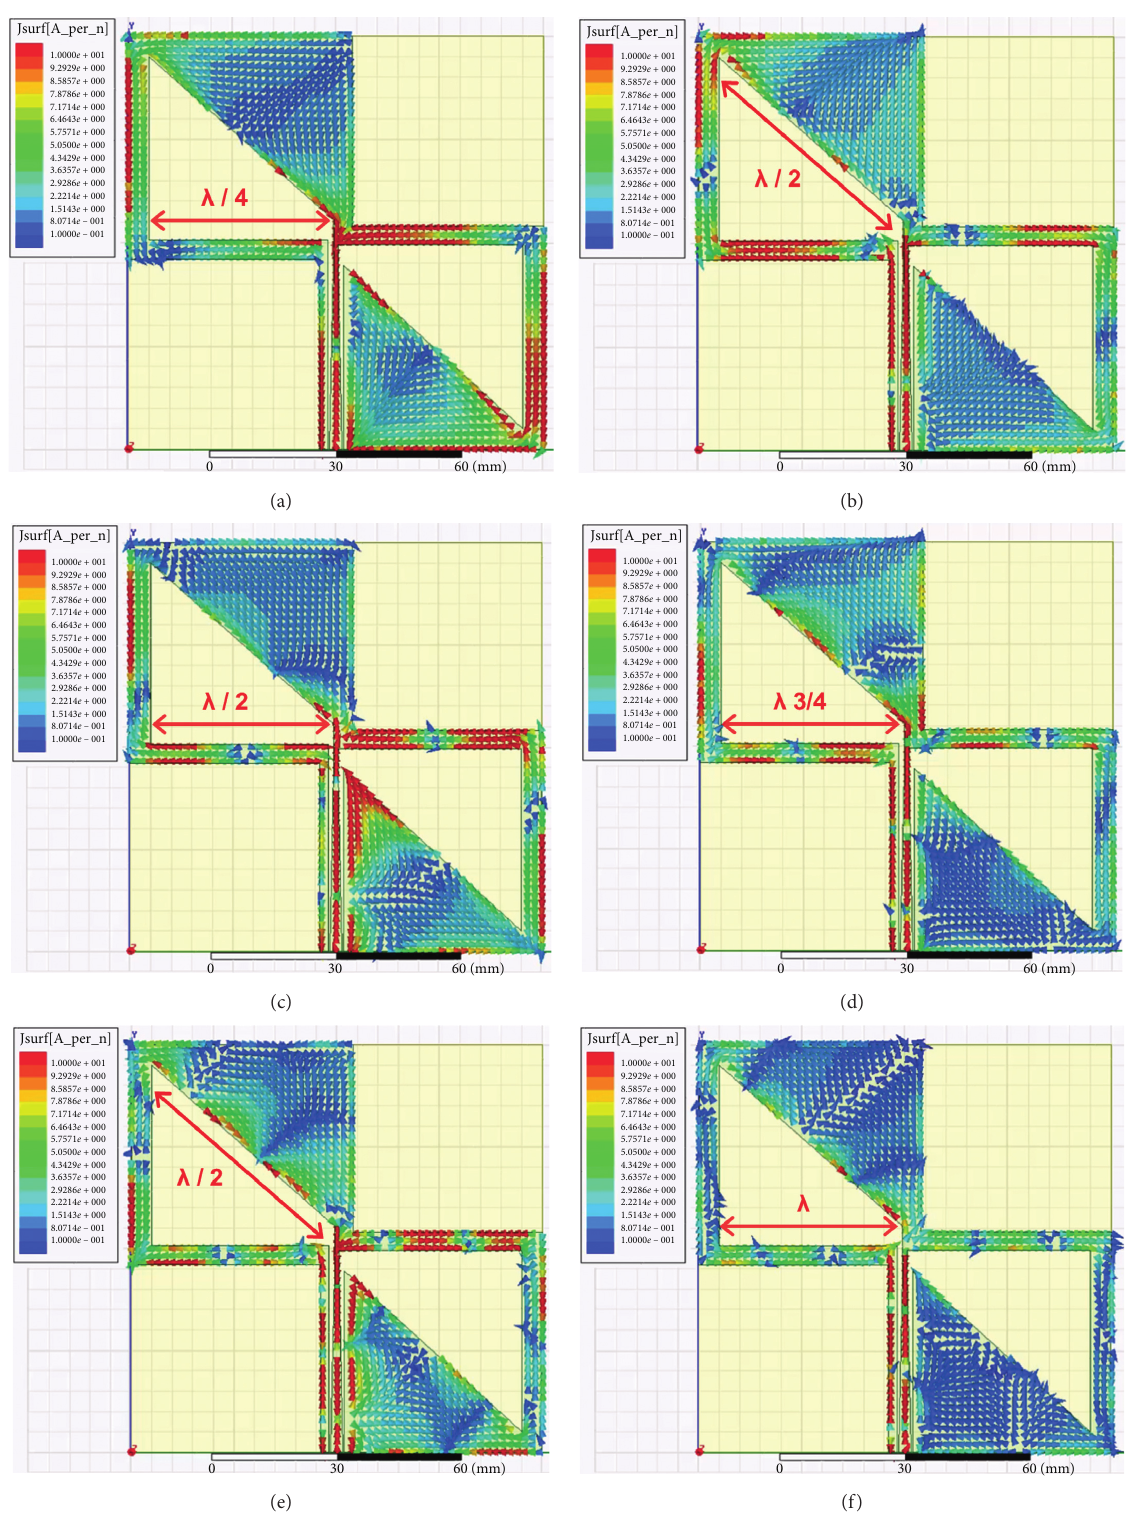
Figure 2: The relationship between the equivalent current distributions of demand frequency and the fundamental resonance wavelength path. (a) 1.575GHz, (b) 2.400GHz, (c) 3.5GHz, (d) 4.7GHz, (e) 5.8GHz, and (f) 6.5